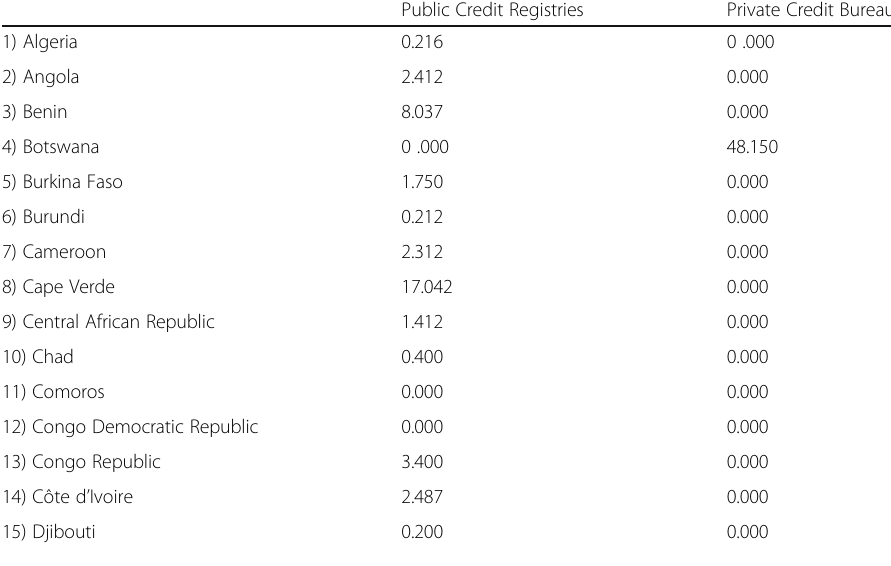
Table 12 Country-specific average values from information sharing